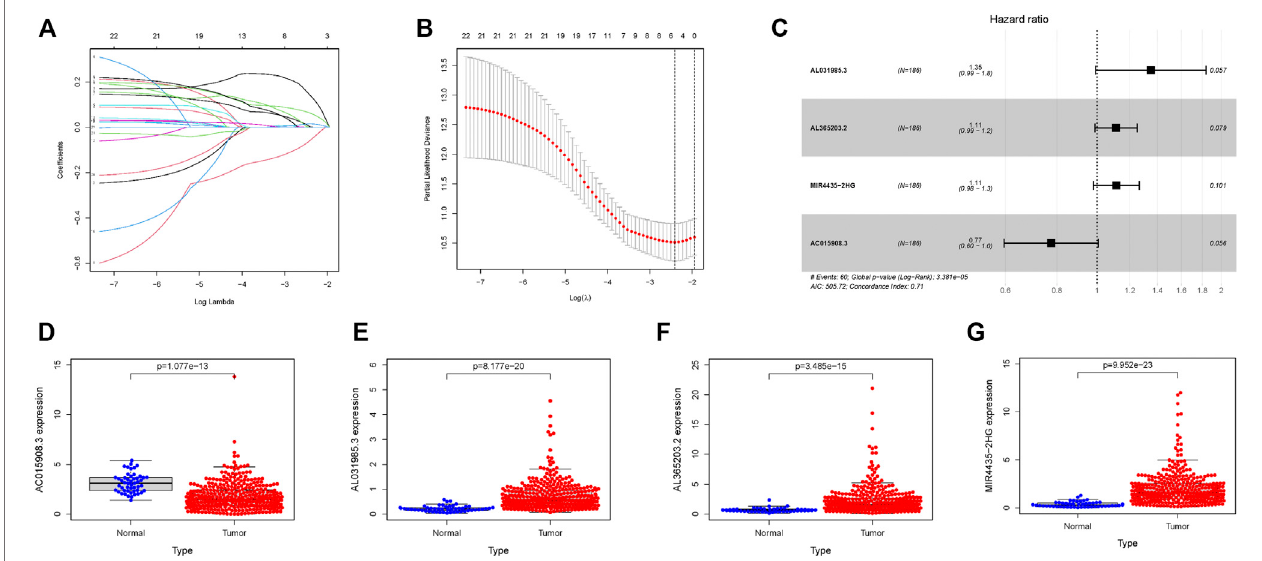
FIGURE1 | Four glycolysis-related lncRNAswith prognostic valuein the training set. (A) Plots for LASSO expression coef fi cients of 22glycolysis-related lncRNAs. (B) Cross-validation plot for the penalty term. (C) Relationship between four glycolysis-related lncRNAs and prognosis of HCC patients (D – G) Expression of four glycolysis-related lncRNAs in tumors and normal tissues; the data come from TCGA database, where all p values < 0.05.